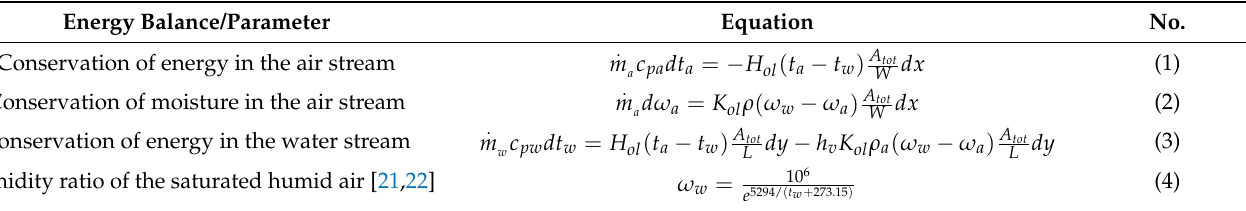
Table 2. Mathematical model equations for membrane evaporative cooler